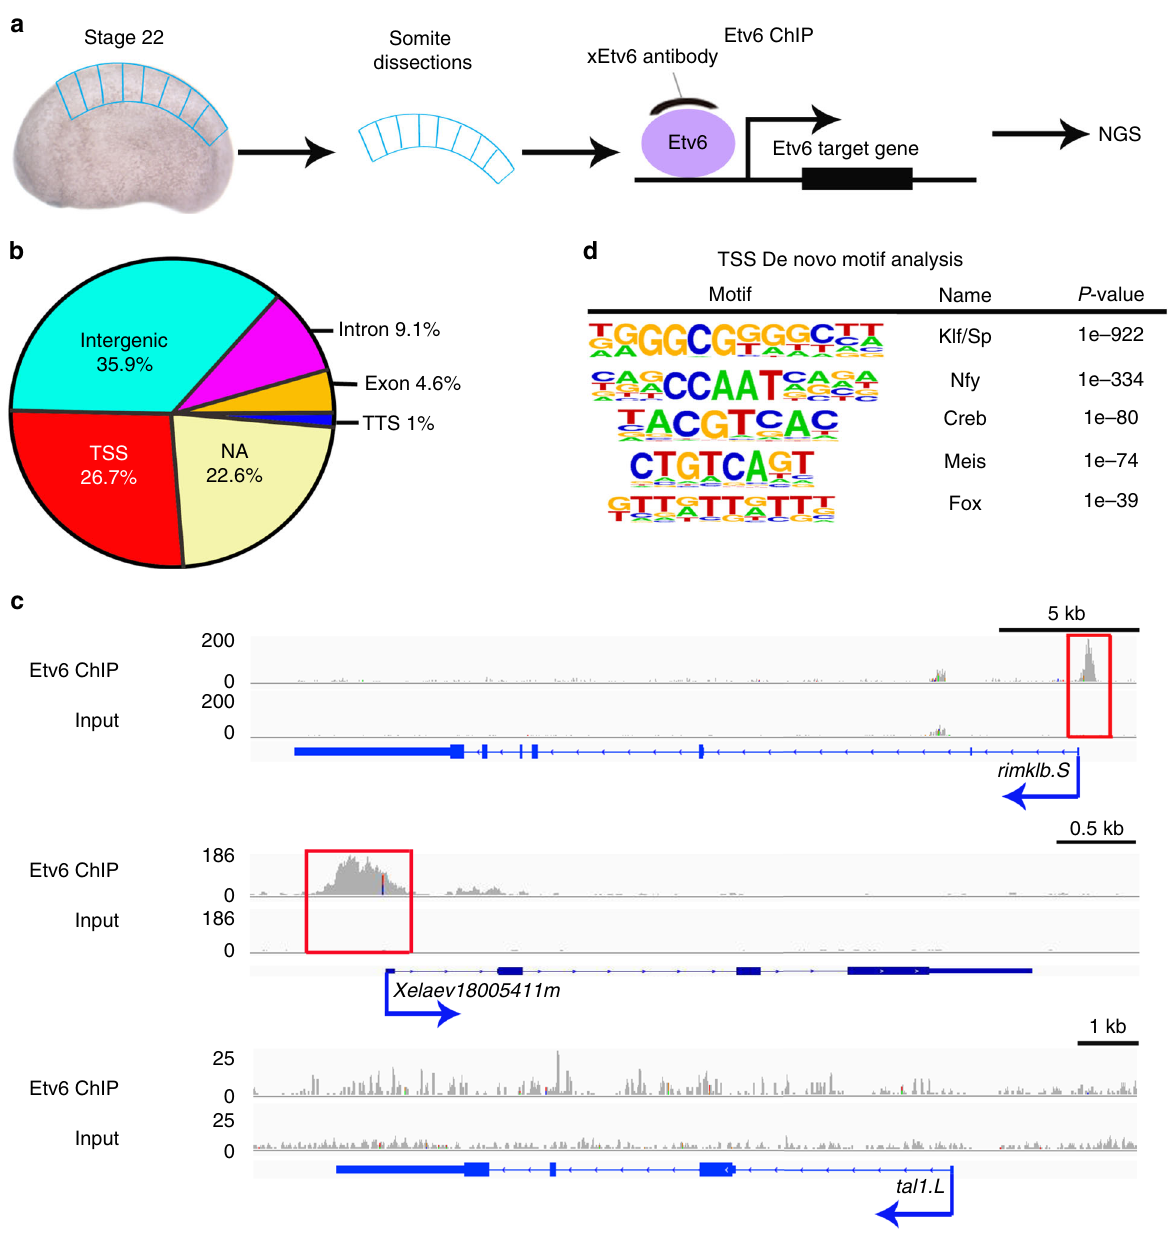
Fig. 1 Genome-wide occupancy of Etv6 in Xenopus somites at stage 22. a Experimental design of Etv6 ChIP-seq assay. The somites were dissected from stage 22 Xenopus laevis embryos, homogenized and fi xed, and subjected to Etv6 ChIP-seq. NGS, next-generation sequencing. b Genomic distribution of the 9128 Etv6 ChIP-seq peaks throughout the X. laevis genome. NA, not annotated; TSS, transcription start site; TTS, transcription termination site. c Integrative genome viewer (IGV) showing examples of Etv6 ChIP-seq tracks. Etv6 binding is enriched in the TSS region of rimklb.S and Xelaev18005411m (red boxes) but not in the TSS region of tal1.L . Input is shown as control. The consensus peaks were generated using DiffBind; for the peak tracks of individual replicates, see Supplementary Figure 13. d De novo motif analysis of ETV6 peaks located in the TSS region. Five out of the 22 overrepresented motifs are